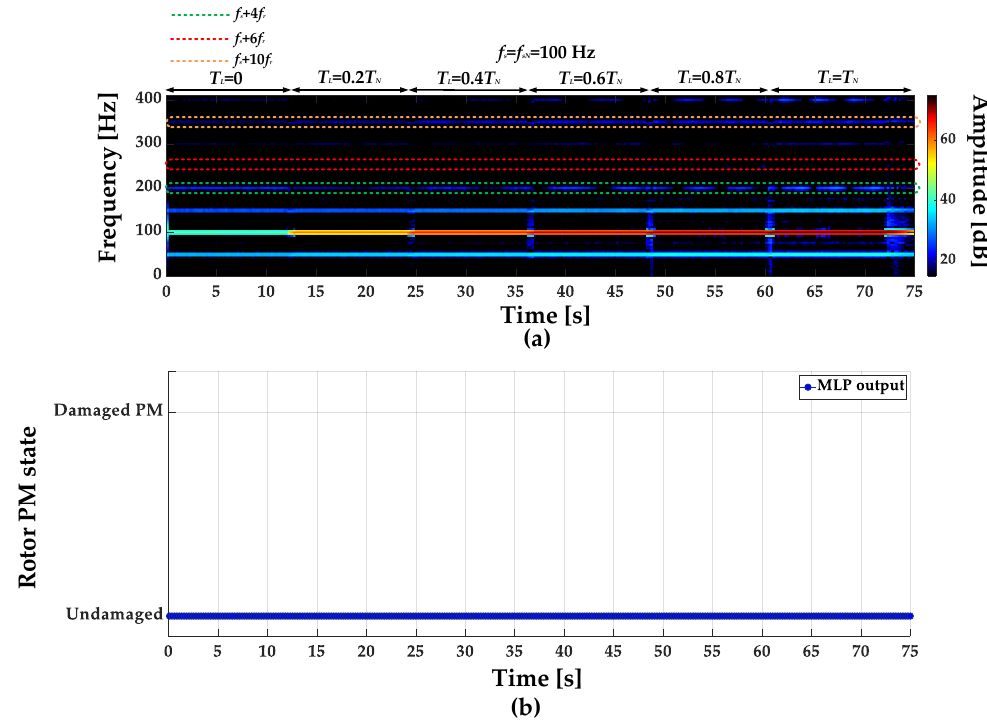
Figure 23. ( a ) Part of the stator phase current STFT spectrogram, ( b ) response of the MLP-based fault detector for undamaged rotor ( T L = var, f s = f sN = 100 Hz).